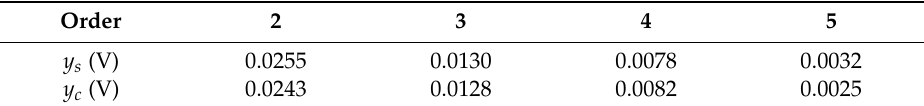
Table 1. Harmonics in signals.